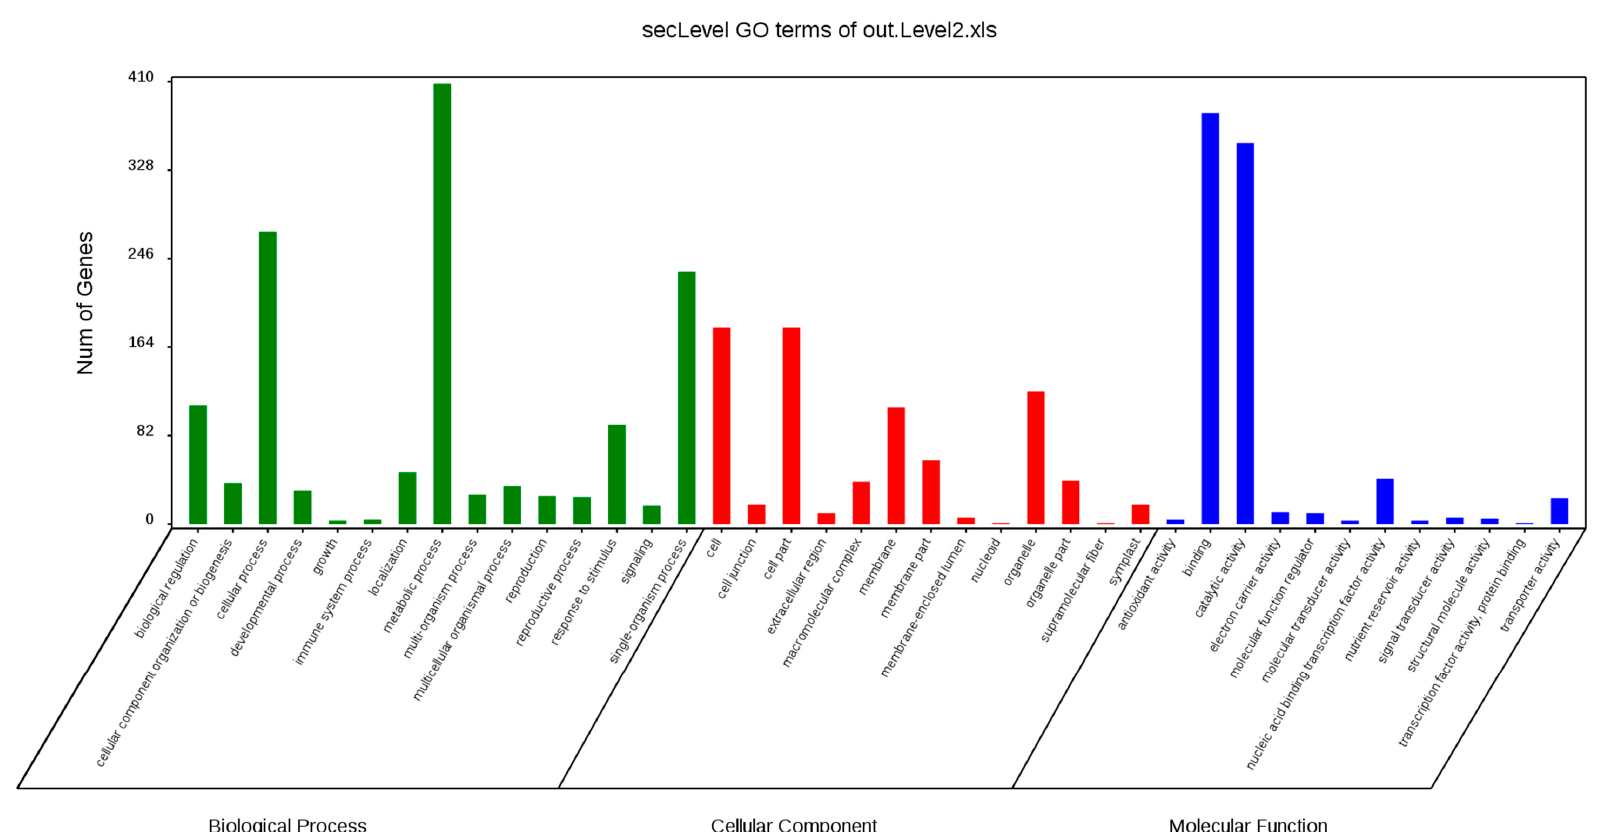
Figure 13. Classification of GO of GCN.